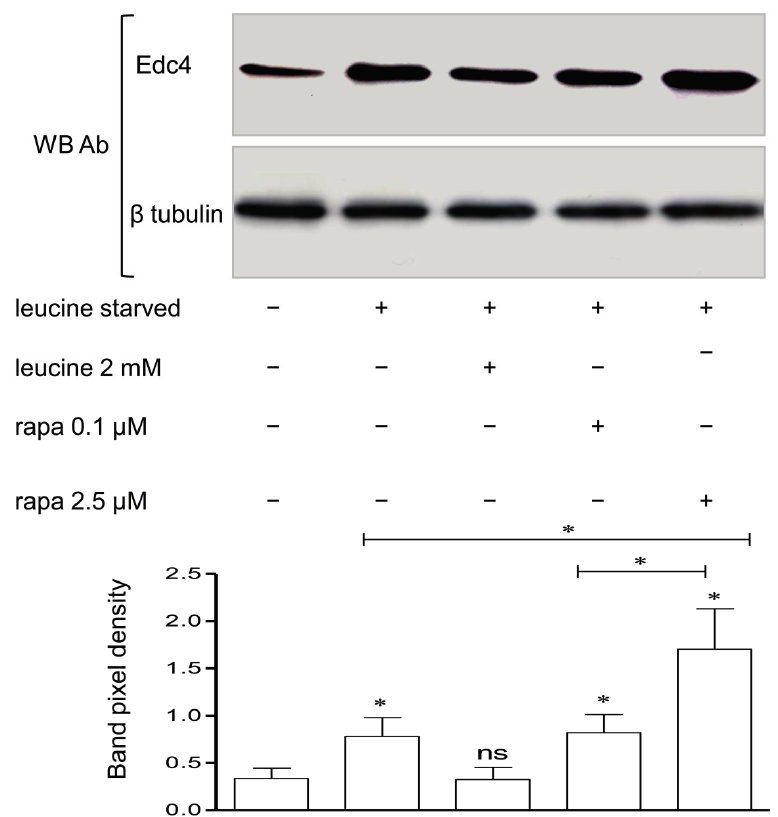
Figure 4. Leucine starvation and rapamycin treatment increased Edc4 protein expression: CCRF-CEM cells were grown, treated and lysed as described in methods section. Immunoblotting with Edc4 antibody detected significant change in the Edc4 expression in leucine starved and rapamycin treated cells as compared to control (without